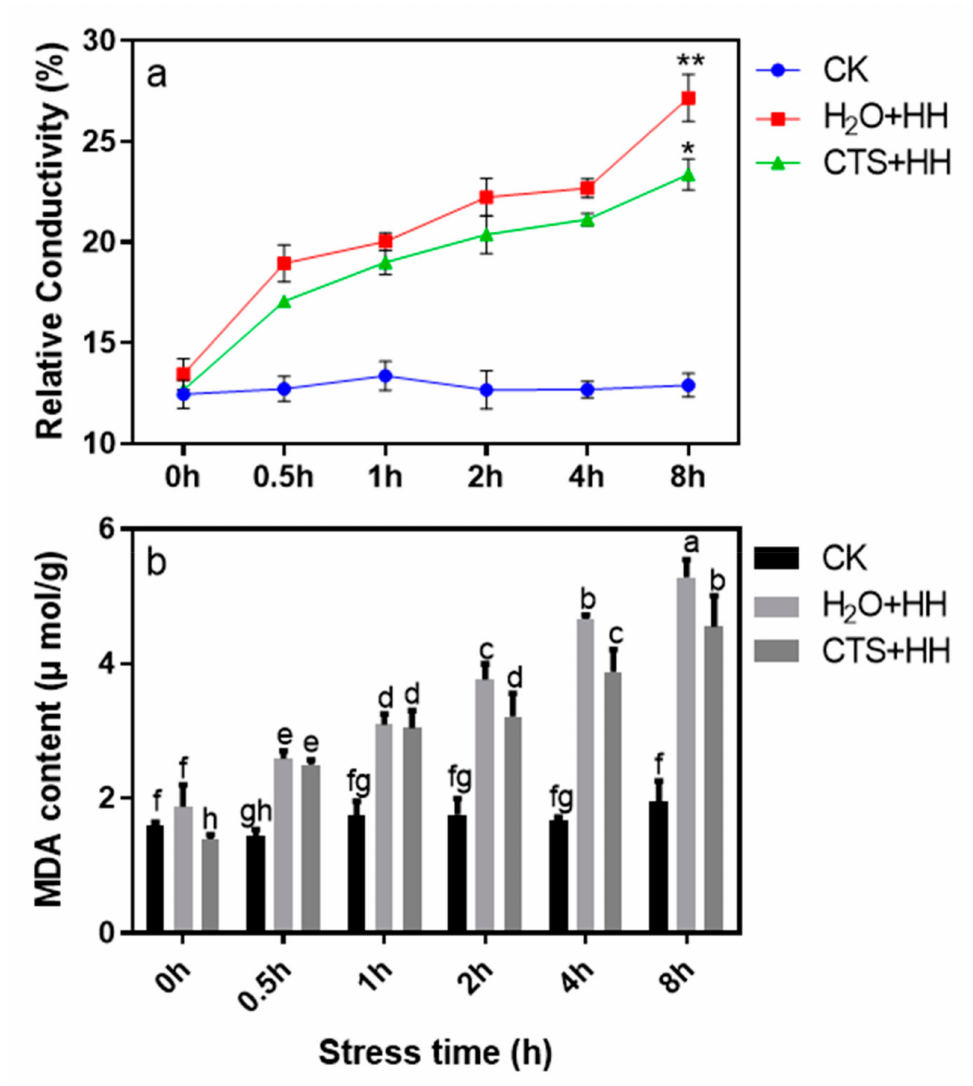
Figure 4. Effects of CTS on the degree of membrane peroxidation of strawberry seedlings under high-temperature and high-light stress. ( a ) electrical conductivity; ( b ) malondialdehyde content, MDA content. CK: H 2 O + 23 ◦ C + 400 µ mol · m − 2 · s − 1 ; H 2 O + HH: H 2 O + 38 ◦ C + 1800 µ mol · m − 2 · s − 1 ; CTS + HH: CTS + 38 ◦ C + 1800 µ mol · m − 2 · s − 1 . * and the different lowercase letters indicate that